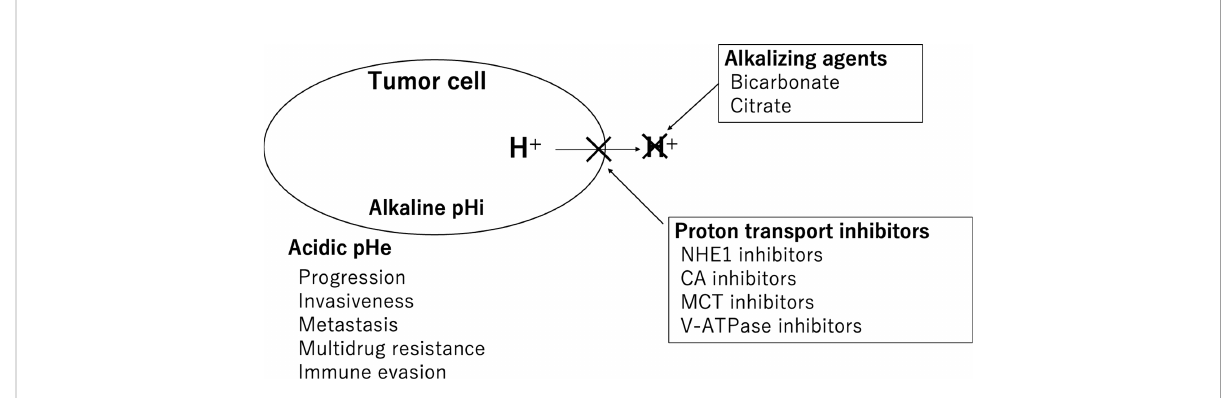
FIGURE 1 Therapeutic approaches targeting the acidic pH of the TME. Alkalizing agents and proton transporter inhibitors are